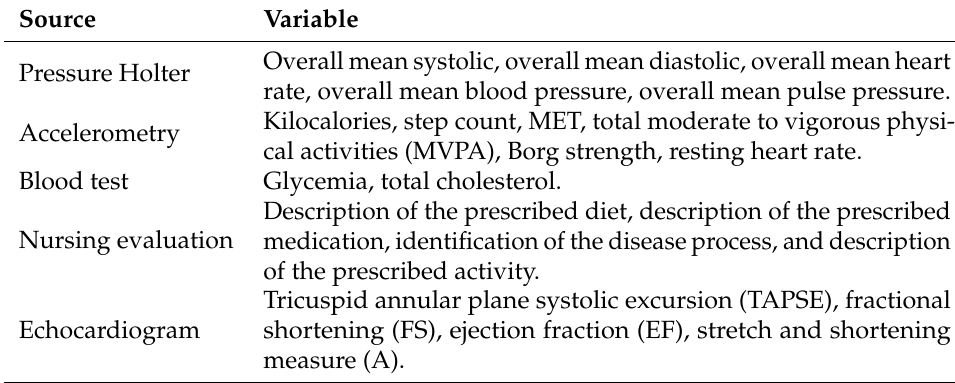
Table 3. Additional variables from new patients for developing the proposed